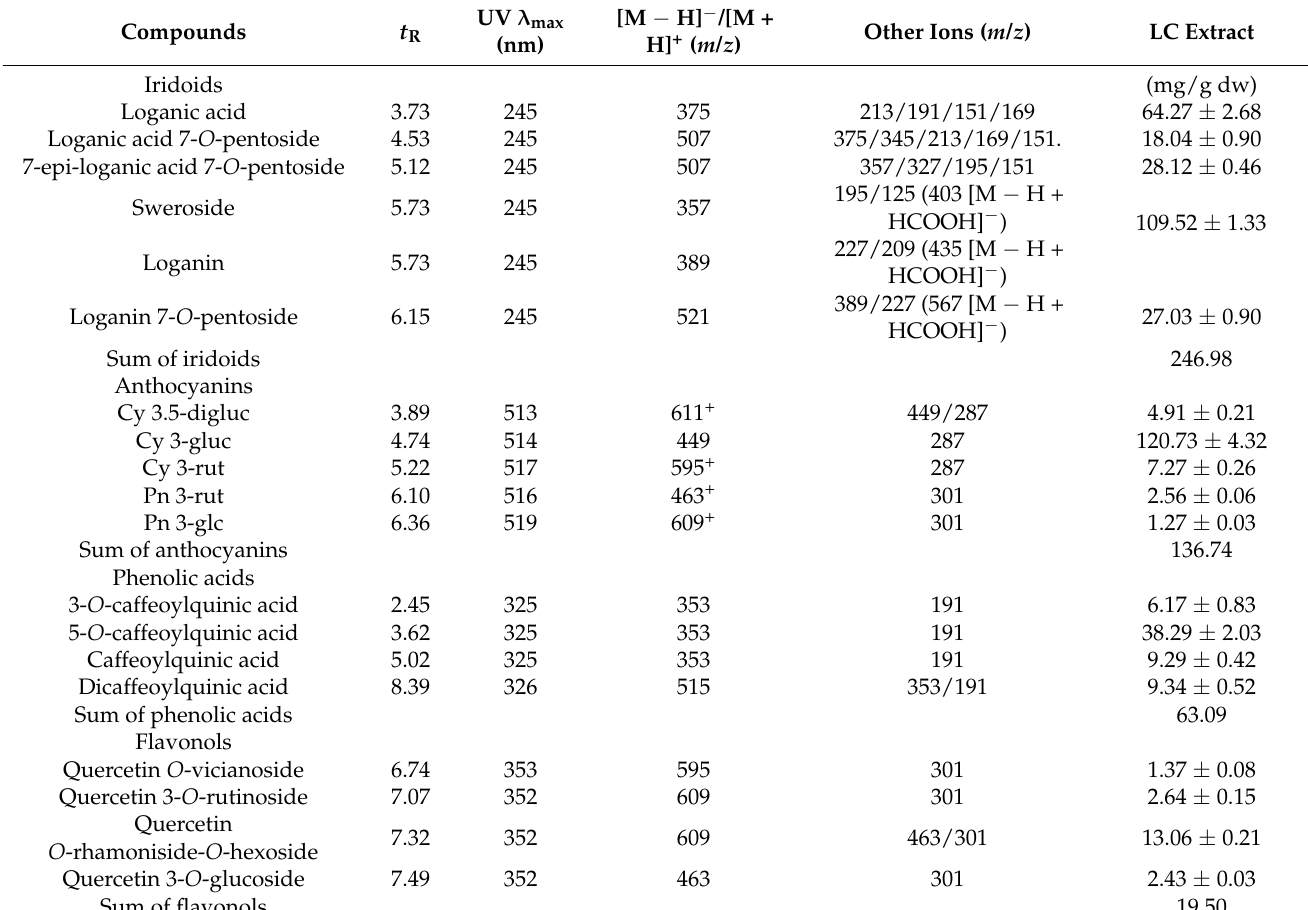
Table 11. Identification and content (mg/g dw) of main compounds of honeysuckle berry (LC) extracts by UPLC-ESI-qTOF-MS/MS and